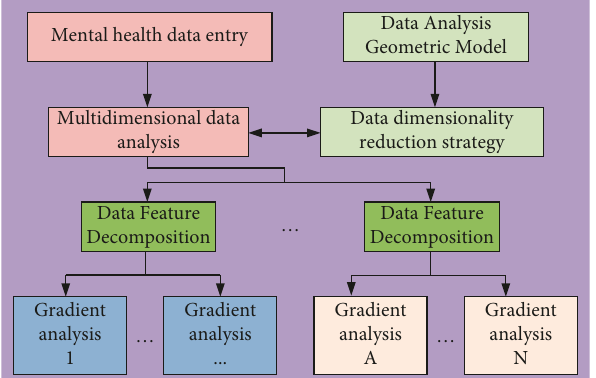
Figure 2: Decoupling and analysis operation process of multidi- mensional data of mental health by enhanced convolutional neural network based on multidimensional data analysis